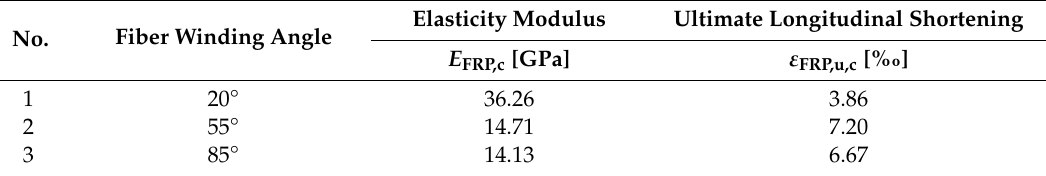
Table 3. Computed results of longitudinal elasticity modulus and ultimate shortening of tested pipe composite during compression.